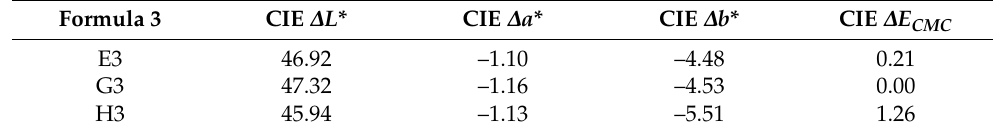
Table 12. The coating color differences of coated panels prepared by Formula 3.